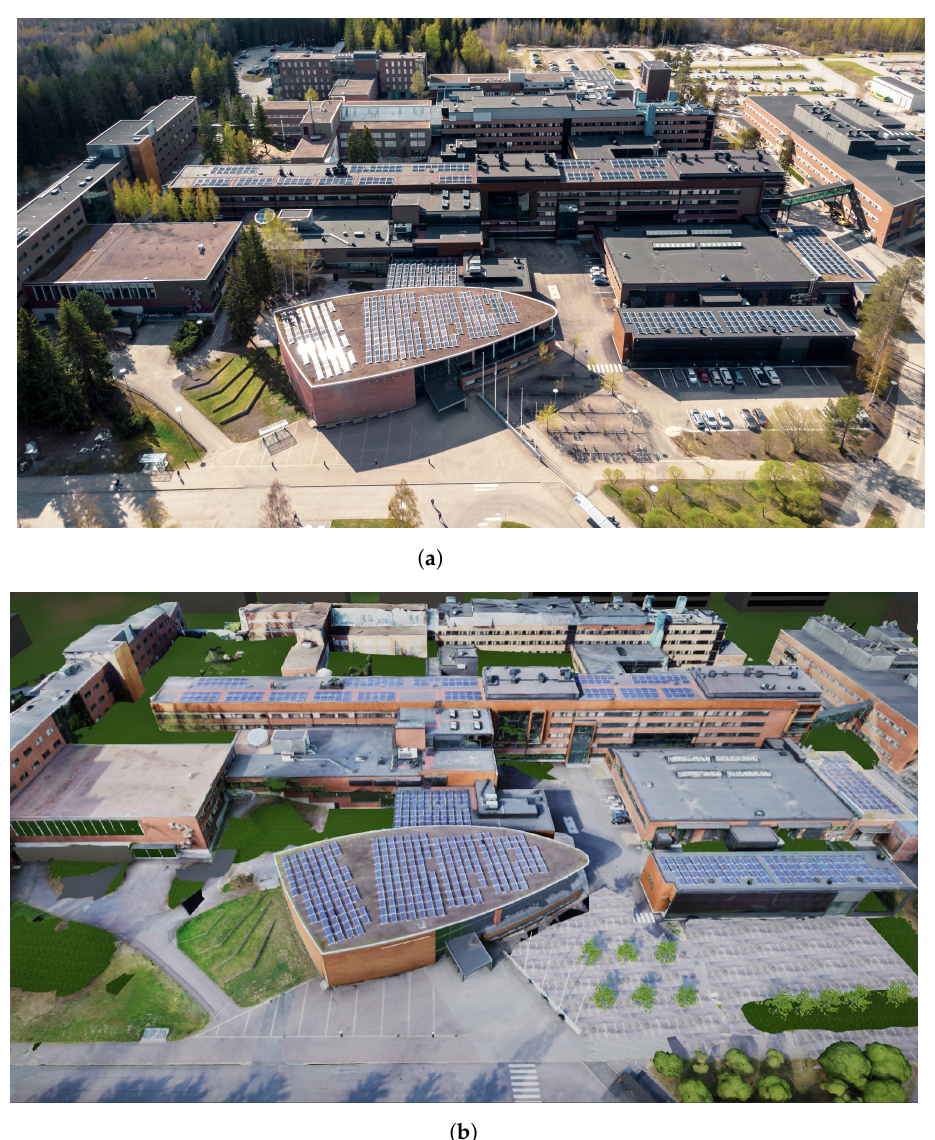
Figure 11. A comparison between the LUT campus buildings in real world and in the graphical software using the photogrammetry approach: ( a ) Real world and ( b ) Unity